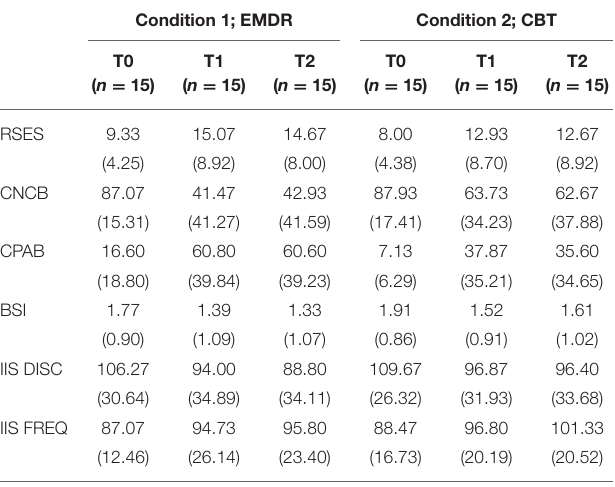
TABLE A1 | Means (SD) of the outcome measures of intention to treat